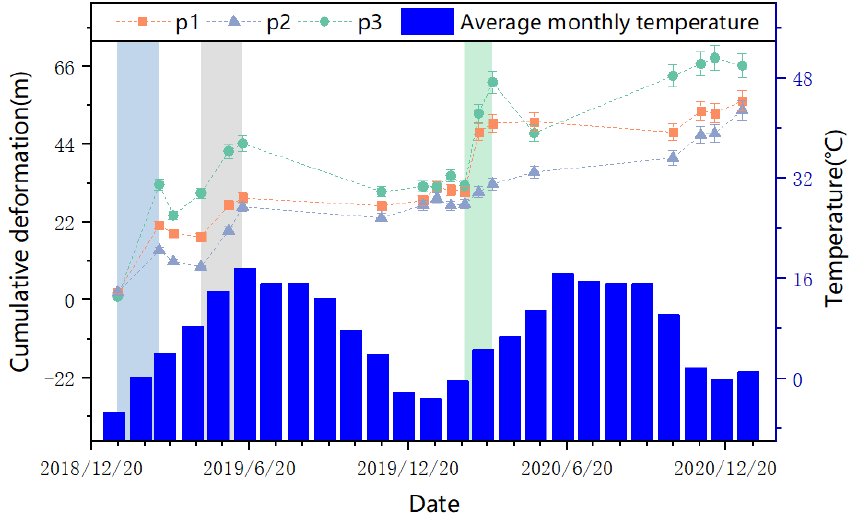
Figure 16. Relationship between optical horizontal time-series deformation and temperature in the glacial study area (error bar is calculated as 5% of the data). P1, P2, and P3 are shown in Figure 7c. The average monthly temperature data are from the Xigaze weather station on the world weather website (https://rp5.ru/ (accessed on 26 July 2022)).